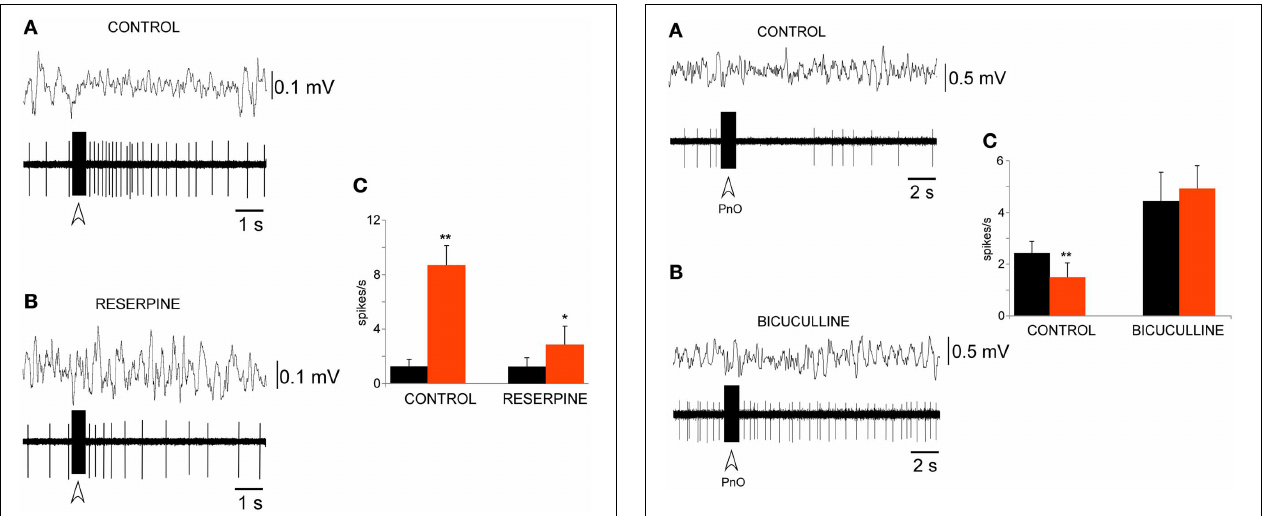
FIGURE 5 | LC stimulation evoked a long–lasting excitation of PeFLH neurons. (A) Train stimulation of the LC evoked an increase of PeF neuronal activity for 3s, with a simultaneous decrease in EEG slow waves. The stimulation train is indicated by the open arrow. (B) LC-evoked excitation was abolished in a reserpine-treated animal. (C) Plot of the mean firing rate calculated for the 10s period before (black) and after (red) LC stimulation train in control animals ( n = 21 cells) and in reserpine-treated animals ( n = 12 cells). The LC-evoked excitation of PeFLH neurons was reduced after catecholaminergic depletion. The asterisk indicates significant statistical differences ( ∗ p < 0 . 05; ∗∗ p < 0 . 01).